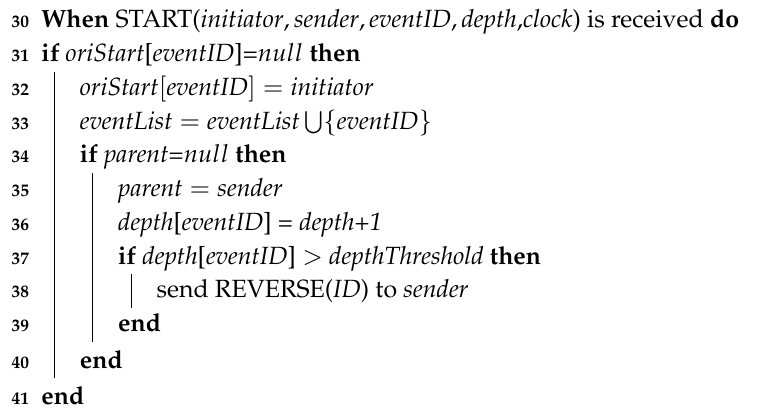
Algorithm 3: Asynchronous Distributed Data Collection Approach (shop)